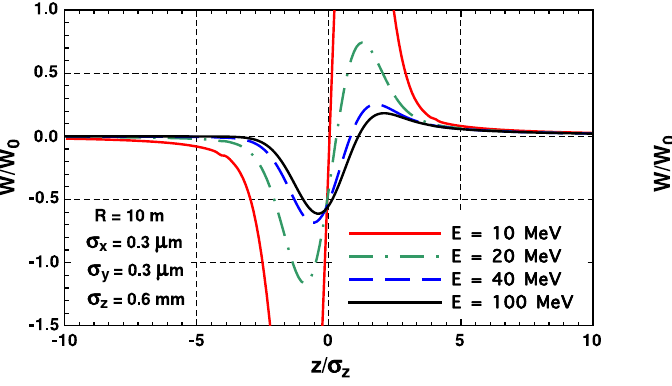
FIG. 19. (Color) The full ( CSR þ SC ) steady-state kick as a function of longitudinal position for four different energies between 10 and 100